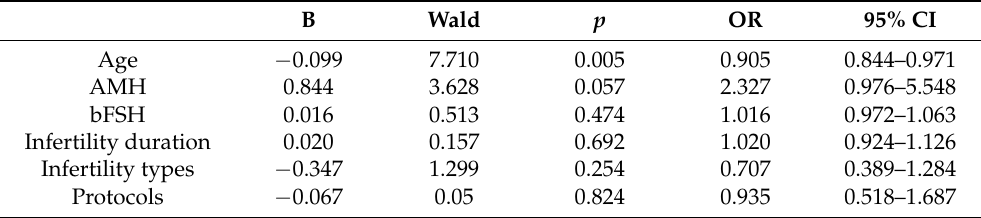
Table 5. Multivariate logistic regression analysis of live birth